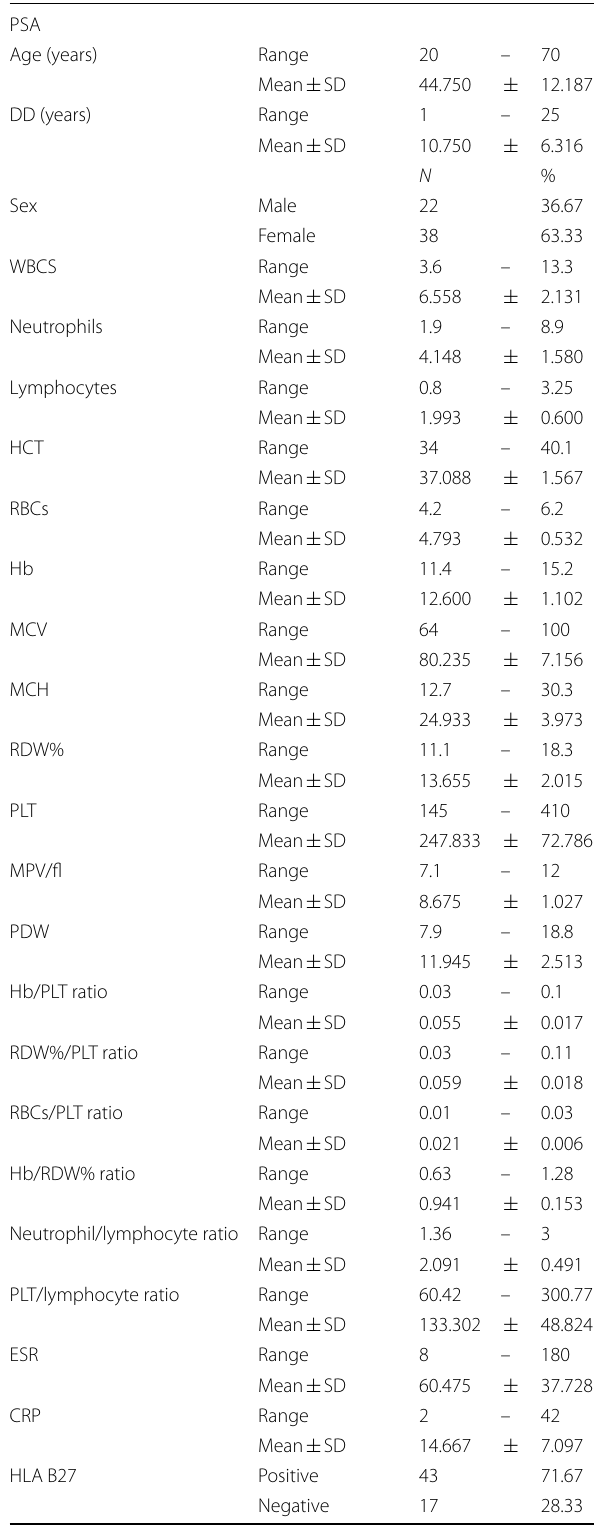
Table 1 Descriptive data of PsA